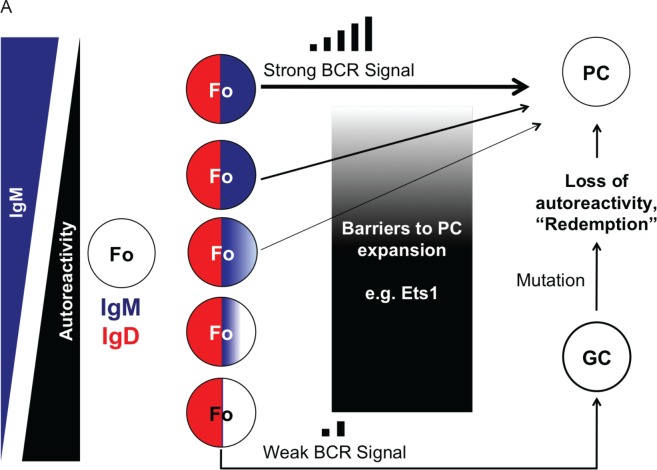
Role of IgM and IgD in regulating rapid antibody responses.(A) Model: Control of peripheral B cell tolerance by IgM and IgD. Selective downregulation of IgM is a well-described feature of autoreactive B cells. This study demonstrates how loss of IgM could desensitize autoreactive B cells towards self-antigens. High and invariant IgD expression provides survival signals to allow these autoreactive cells to be maintained in the repertoire. Upon activation by foreign antigen, the least autoreactive cells receive strong signals through IgM and can quickly differentiate into plasma cells with little danger of autoimmunity. In contrast, the most autoreactive B cells are activated through IgD, which is less efficient at transducing signals in vivo. This weak signaling shunts IgDhi IgMlo cells into the germinal center where they can be ‘redeemed’ via somatic hypermutation, as proposed by Goodnow and colleagues. In this way, dual expression of IgM and IgD expression facilitates repertoire diversity and balances immune responsiveness with autoimmune potential.